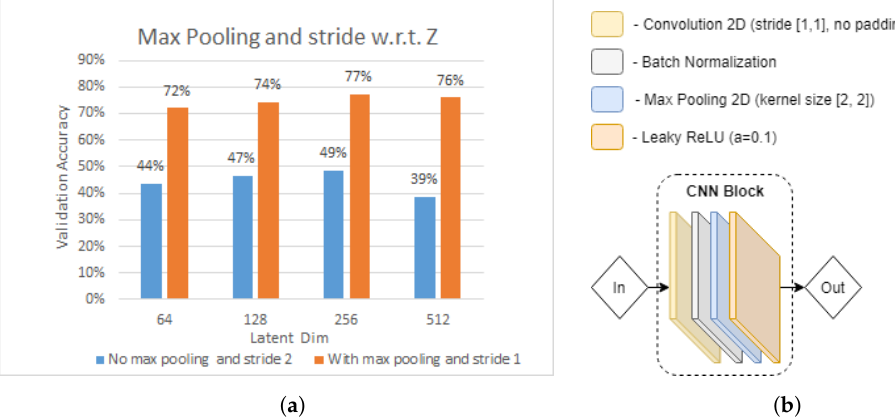
Figure 14. Effect of adding max pooling and changing convolution kernel stride. ( a ) Test accuracy of CNN feature extractor max-pooling and stride w.r.t latent dimension z experiment. ( b ) Feature extractor CNN